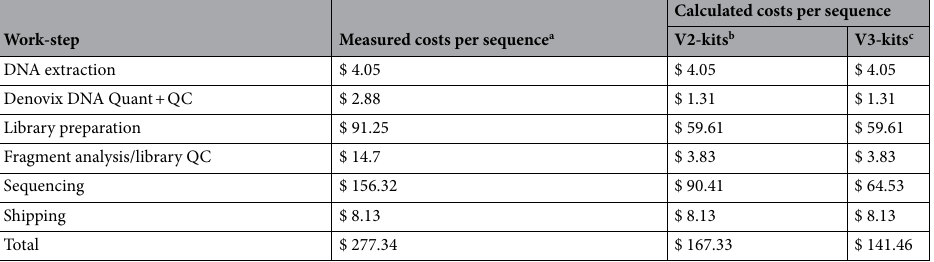
Table 2. Sequencing and reagent costs per sequence measured during implementation, and calculated costs per sequence using V2-kits or V3-kits once NGS has been established and staff have been properly trained. a Measured for first 174 sequences. b Theoretical costs based on 16 samples/run. c Theoretical costs based on 30